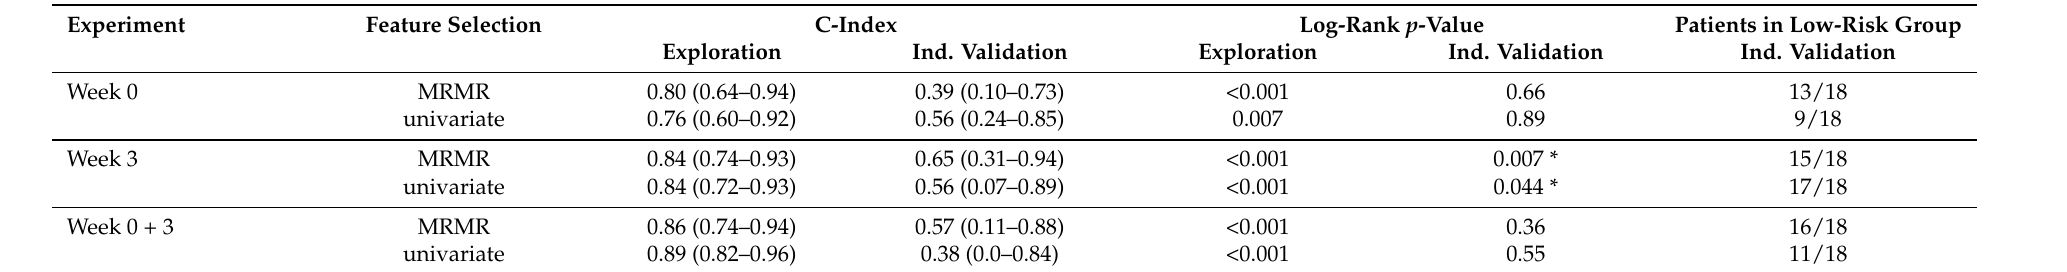
Table 5. Final signature model performance (CT + FDG-PET): Values in parenthesis denote 95% confidence intervals based on bootstrapping. Values in bold denote the best performance (C-index) and statistically significant stratification (Log-rank p -value) for the independent validation cohort. The last column provides the fraction of patients assigned to the low-risk group based on the prediction cutoff. The number of patients in the low-risk group of the exploratory cohort is always 18 out of 37, as the median prediction was used as the cutoff. * indicates statistically significant p -values for the stratification that produced highly imbalanced groups for low and high risk of loco-regional